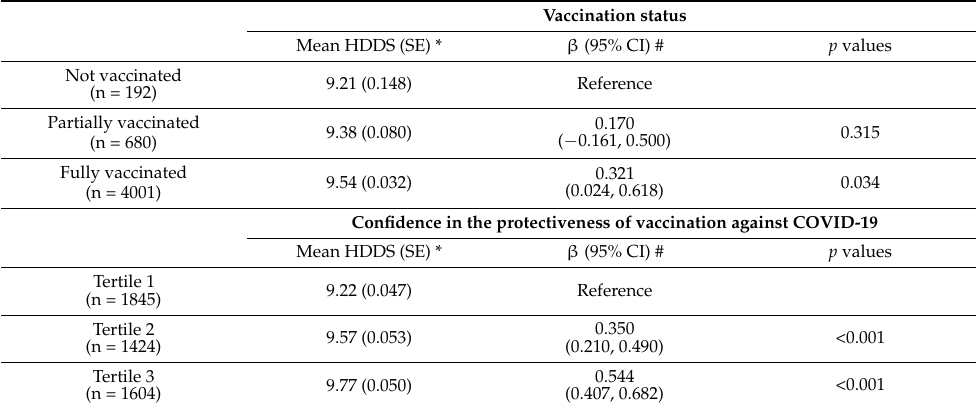
Table 3. Household dietary diversity score by vaccination status and rate of confidence in the protectiveness of the COVID-19 vaccine.